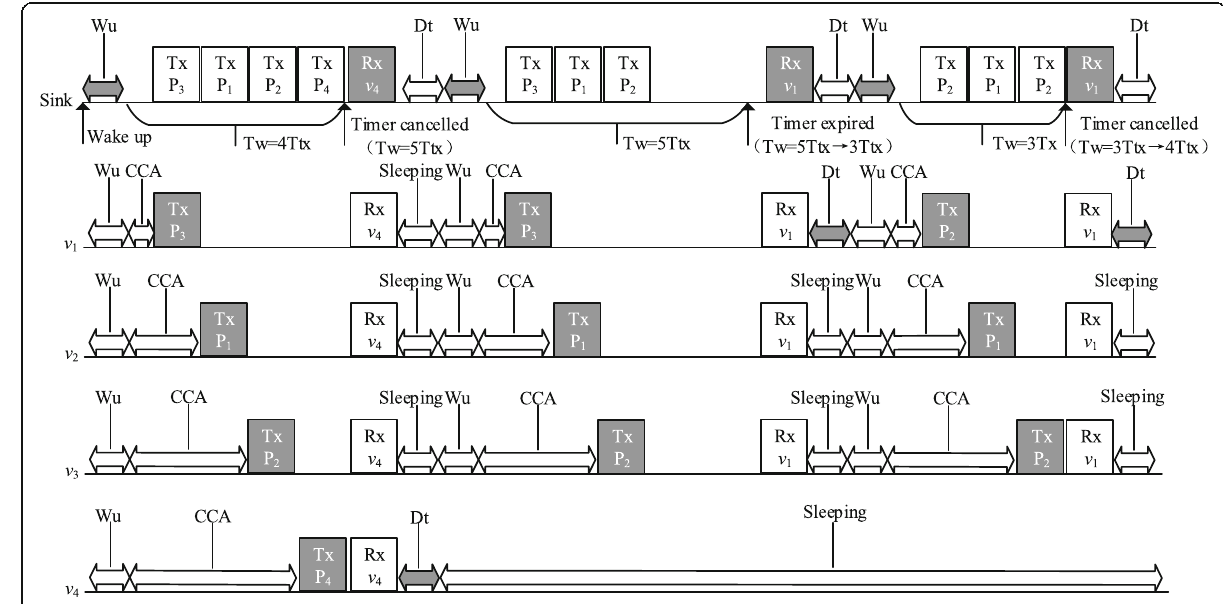
Fig. 11 In network 2, the initial wait time is T w = 5 T x under the transmission process of the DWT-MAC